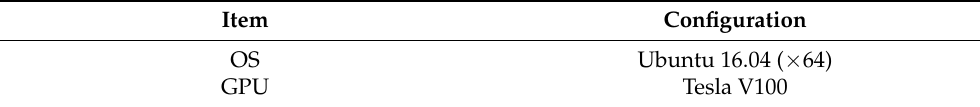
Table 2. Configuration